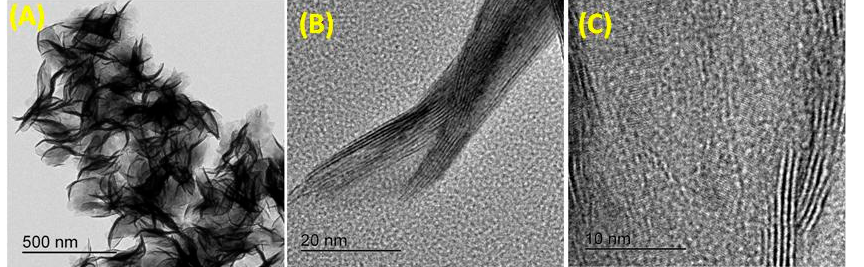
Figure 1. TEM images of MoS 2 : ( A ) low-magnification image; ( B , C ) high-resolution TEM image of layered MoS 2 .